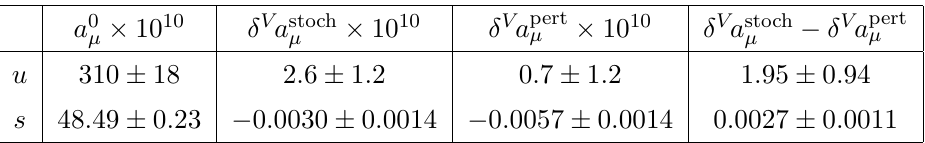
V a Table 3 . The HVP contribution to a (cid:22) without QED and the QED corrections (cid:14) (cid:22) from stochastic and perturbative data at an isospin symmetric pion mass of 340 MeV. Results have been obtained using equation (5.11). The last column (cid:14) V a stoch (cid:0) (cid:14) V a pert shows the correlated di(cid:11)erence between the results from both data